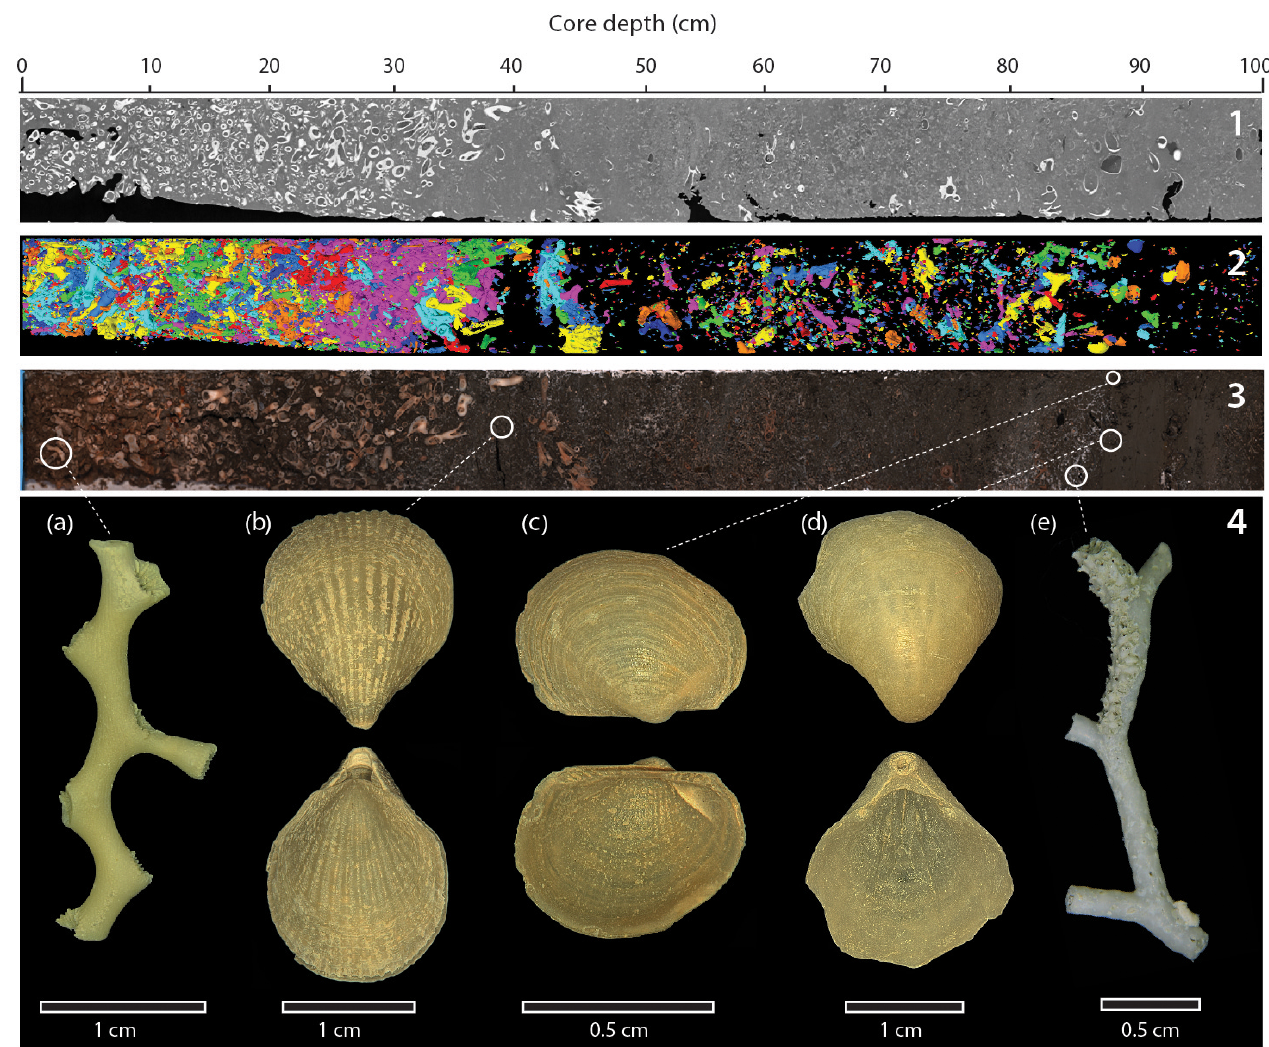
Figure 7. Example of a sediment core section showing the main macrofaunal components (section 1, 0–100cm). (1) X-ray computed to- mography imagery. (2) Three-dimensional reconstruction of coral fragments performed on X-ray CT images. (3) Split-core high-resolution image. (4) Main macrofaunal components: (a) the coral Madrepora oculata , (b) the brachiopod Terebratulina retusa , (c) the bivalve